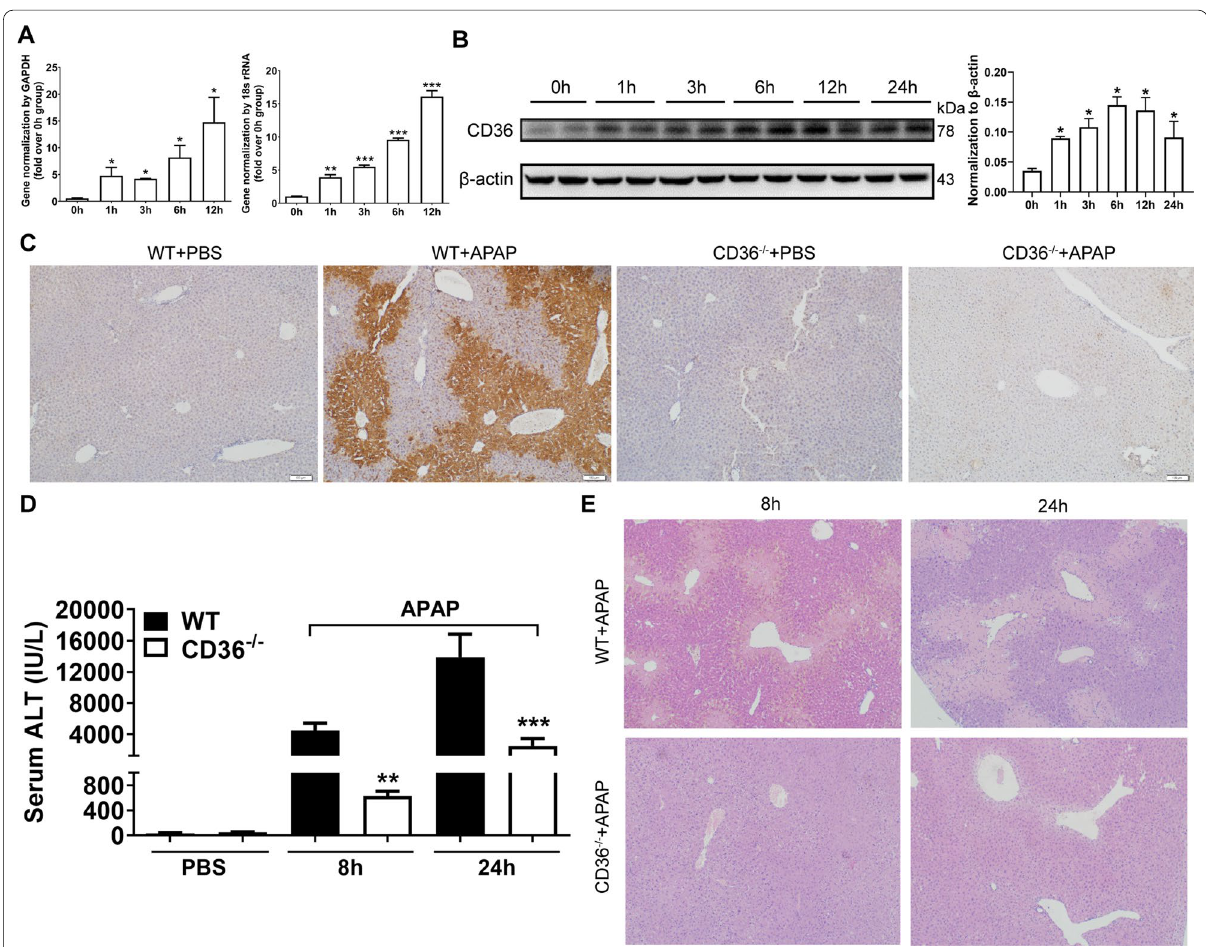
Fig. 1 CD36 deficiency reduced APAP-induced murine liver injury. WT mice were starved for 16 h and i.p. injected with APAP at 300 mg/kg. The expression of CD36 in the liver at specified time point after APAP treatment was determined by A q-PCR and B Western blotting. *p < 0.05, compared with 0 h; C Immunohistochemical staining of CD36 in the liver sections of mice treated with PBS or APAP for 24 h. D Serum ALT and E liver H&E staining at 8 h and 24 h after APAP injection in mice. N 6–8 mice per group. **p < 0.01, ***p < 0.001, compared with WT =